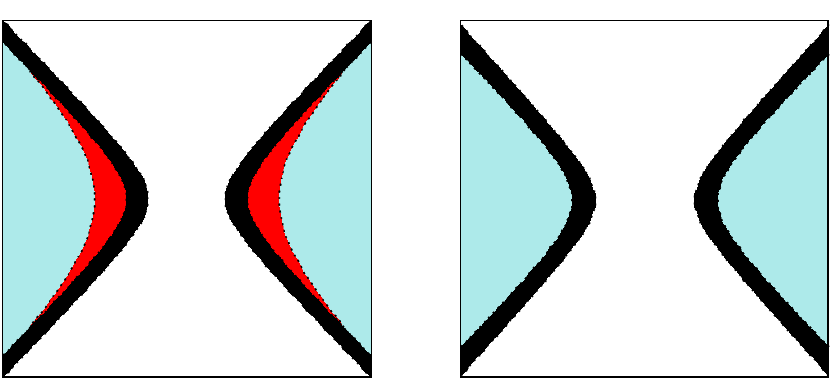
Figure 13 . Phase diagram for Lorentzian modi(cid:12)ed (two boundary) single joining quench geometry with supercritical and subcritical L respectively. We have simply analytically continued the phase boundaries from the Euclidean